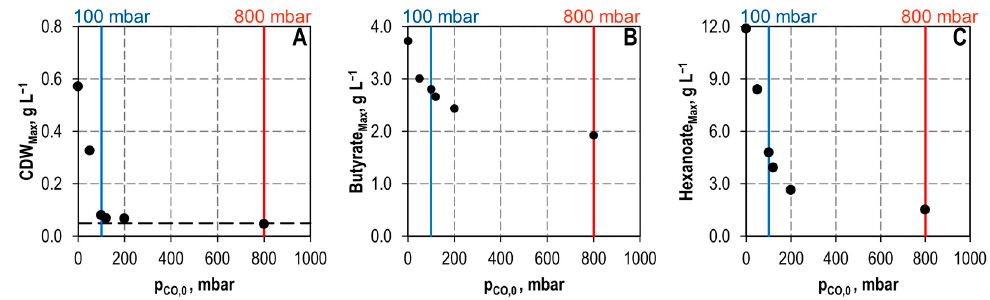
Figure 2. Maximum CDW concentrations ( A ), maximum butyrate concentrations ( B ) and maximum hexanoate concentrations ( C ) as function of varying CO partial pressures during batch cultivations of C. kluyveri with 15 g L − 1 ethanol and 6 g L − 1 acetate in a fully controlled stirred-tank bioreactor. Black do tt ed line shows the initial CDW concentration (T = 37 °C; pH = 6.0; P V − 1 = 11.7 W L − 1 ; F gas = 0.083 vvm with 200 mbar CO 2 ).